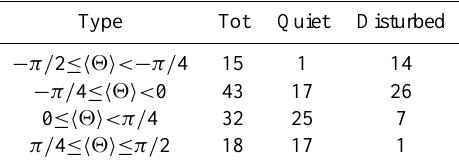
Fig. 7. Quiet Is classified according to h 2 i . Upper panel: plot of MRS vs. time for Case 2 ( − π/ 4 ≤h 2 i < 0, 17 events); Middle panel: plot of MRS vs. time for Case 3 (0 ≤h 2 i <π/ 4, 25 events); Lower panel: plot of MRS vs. time for Case 4 ( π/ 4 ≤h 2 i≤ π/ 2, 17 events).